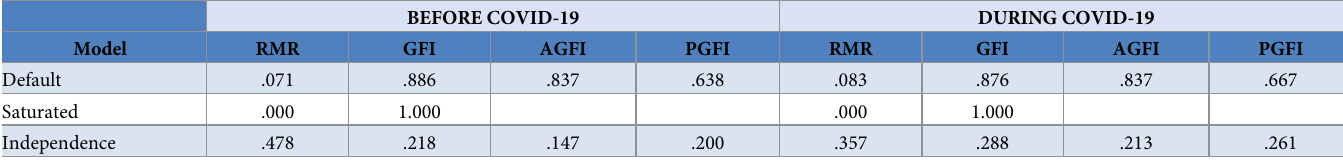
Table 4. RMR, GFI index.